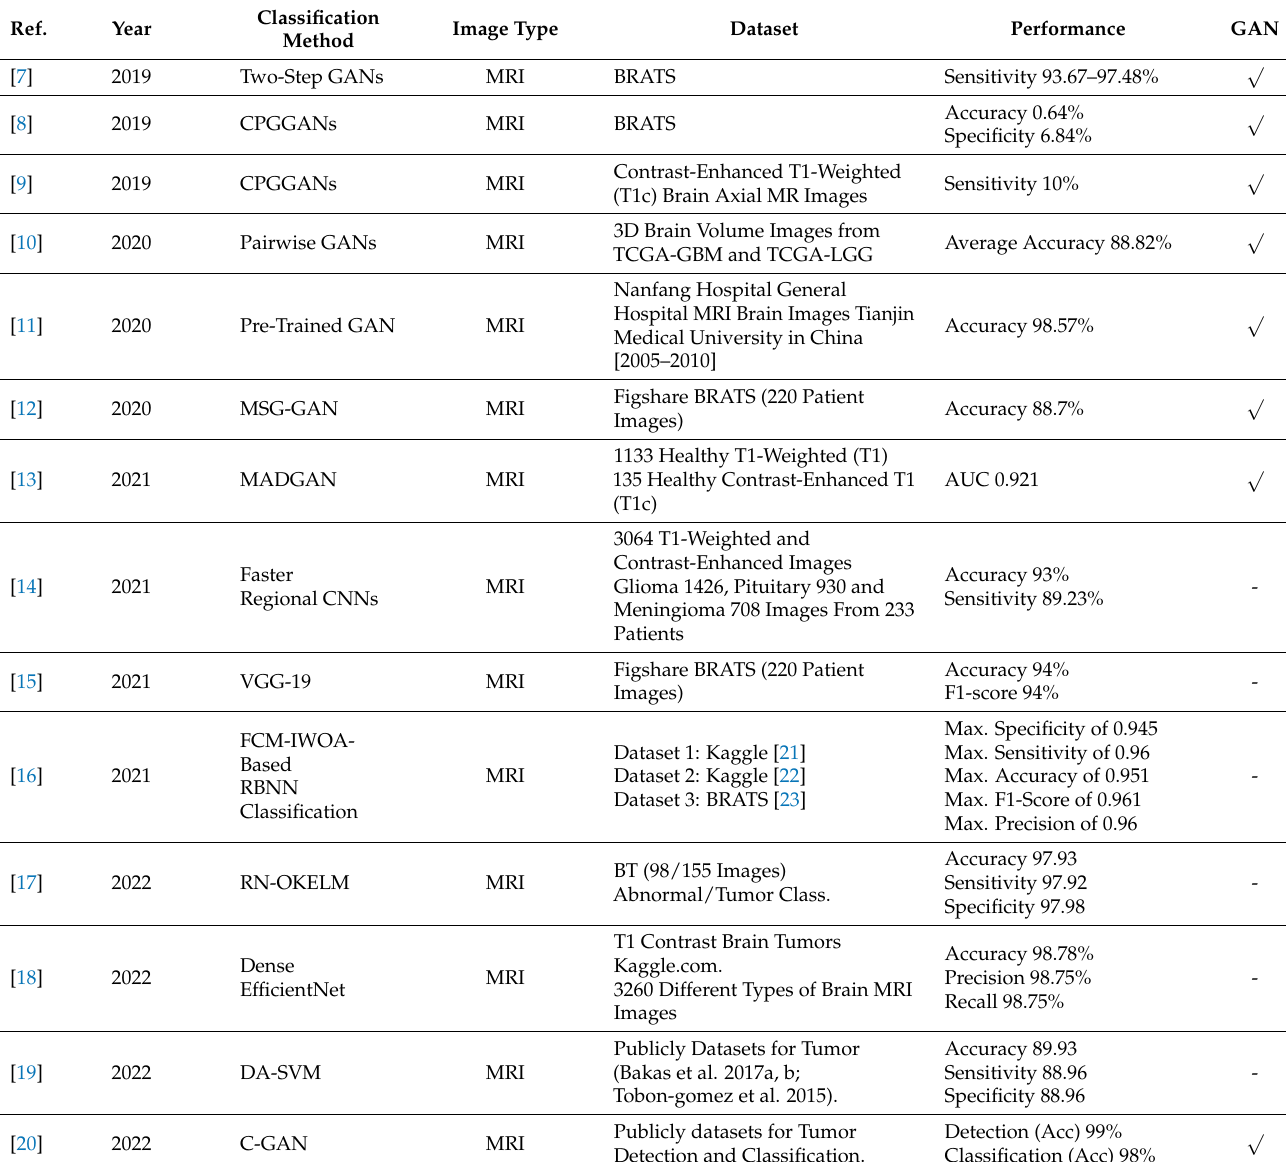
Table 1. A summary of brain-related studies based on MRI